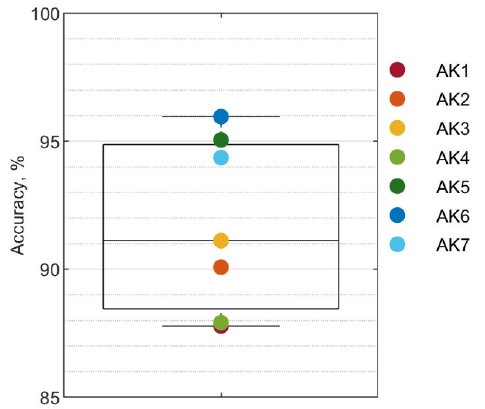
Figure 4. Overall accuracy of sonomyography